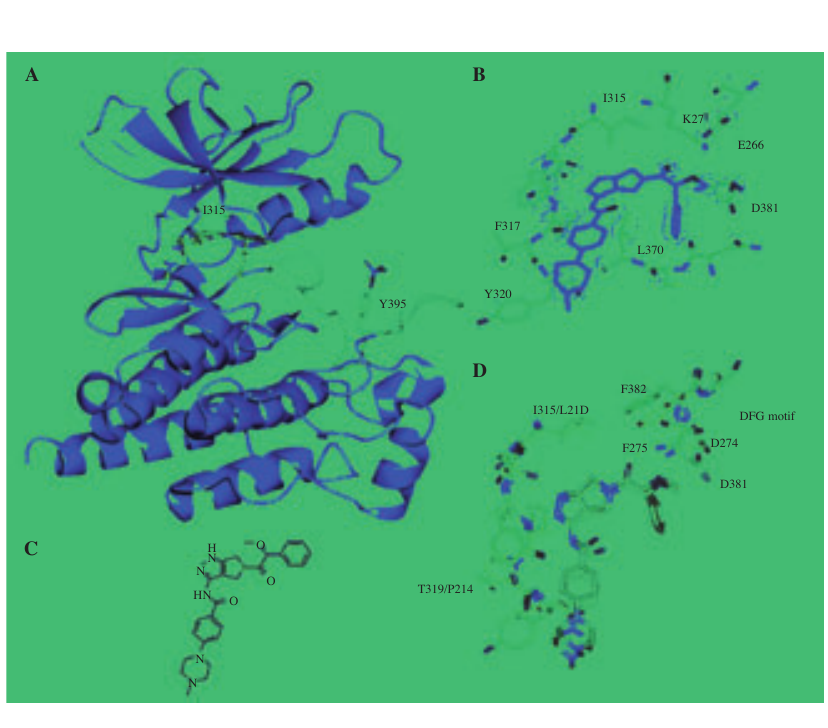
Figure 5. Structure of Abl-T315I-PHA 739358 complex. (A) Ribbon representation of the structure of T315I Abl mutant with PHA-739358. The mutated gatekeeper residue Ile315 and the activation loop with the phosphorylated residue Tyr393 are highlighted in green. (B) Close-up view of the binding site of PHA-739358 showing the final 2 Fo- Fc electron density map, contoured at 1 j, associated with the ligand. (C) Chemical for- mula of PHA 739358. (D) Comparison of PHA-739358 complexes with the aurora A structure. Details of the binding of PHA-739358 to Abl (green carbon atoms) and to aurora A (yellow carbon atoms) showing the residues of the hinge region and of the DFG motif of both proteins. [Reprinted and adapted with permission of AACR from: Modugno M, et al. Crystal structure of the T315I Abl mutant in complex with the auro- ra kinases inhibitor PHA-739358. Cancer Res 2007 Sep 1;67(17):7987-90].